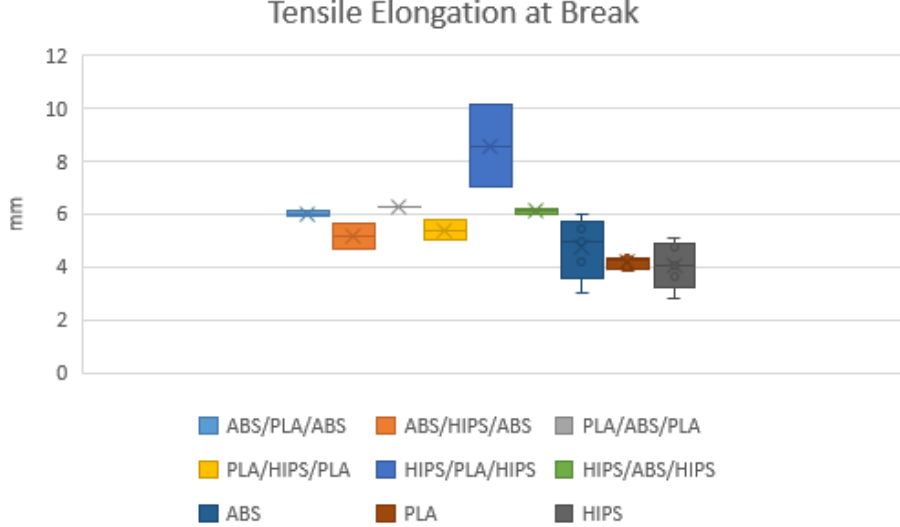
Figure 7. Mean tensile elongation at break of all specimen tested.